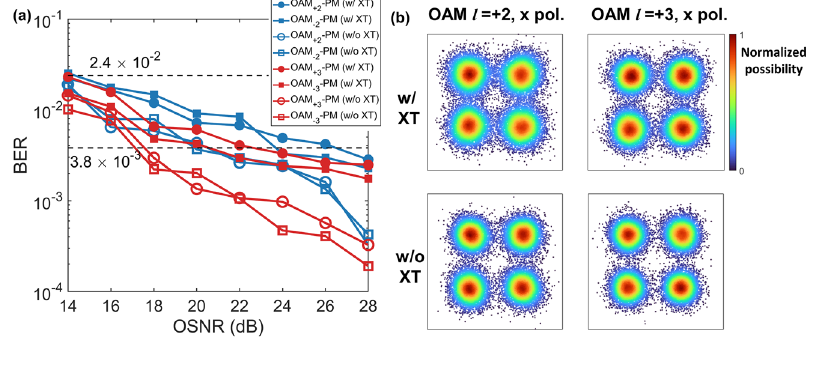
Figure 9: The characterization of the communication system.